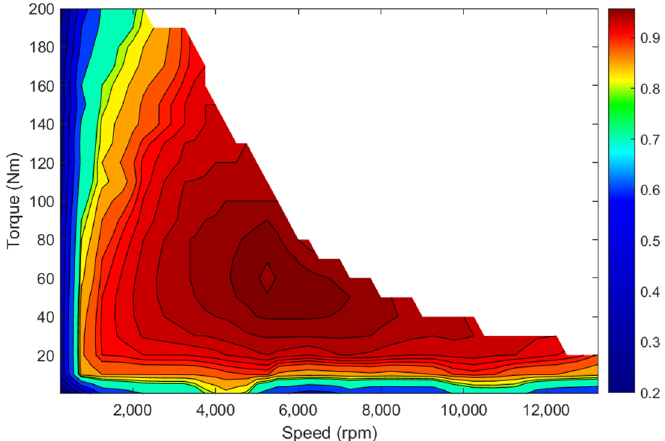
Figure 3. Efficiency contour data of 2010 Prius insulted into TMS controller [19,20].